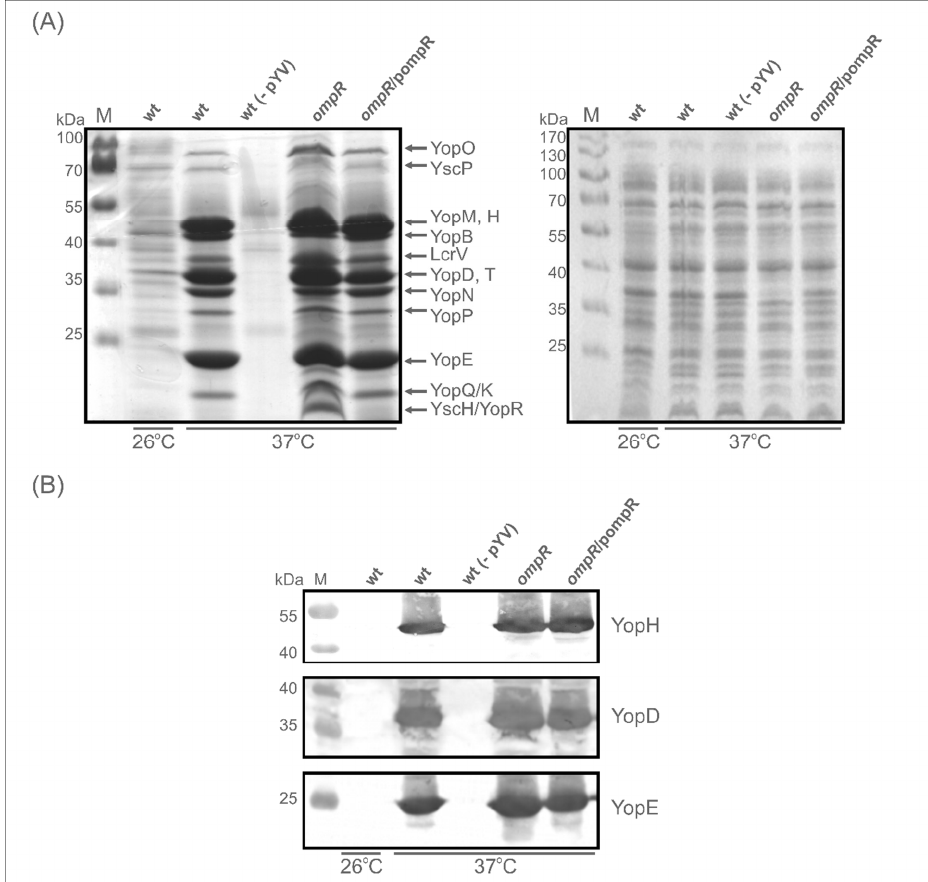
Figure 4. Effect of OmpR on the secretion of Yop proteins examined using 12% SDS-PAGE and Western blotting. ( A ) Yop protein abundance in the culture supernatants of Y. enterocolitica strains Ye9 (wt), Ye9 devoid of pYV: wt (-pYV), AR4 ( ompR ) and complemented strain AR4 ( ompR /pompR), grown under Yop-inducing conditions, i.e., in BHI medium in the absence of Ca 2+ (BHI-MOX) at 37 °C or at 26 °C (only Ye9 (wt)). Proteins from culture volumes containing equal numbers of cells were analysed. Coomassie blue-stained gels of supernatants (left panel) or whole-cell extracts (right panel) of Y. enterocolitica strains are shown. The positions of the secreted proteins (YopO, YscP, YopM, -H, -B, LcrV, YopD, -T, -N, -P, -E, -K/Q, YscH/YopR) are indicated. M, molecular weight standards (PageRuler Prestained Protein Ladder, Thermo Fisher Scientific). ( B ) Western blot analysis of YopH, YopD and YopE proteins in the supernatant samples of the different strains. Immunodetection was performed with specific polyclonal anti-YopH, -YopD and -YopE antibodies.